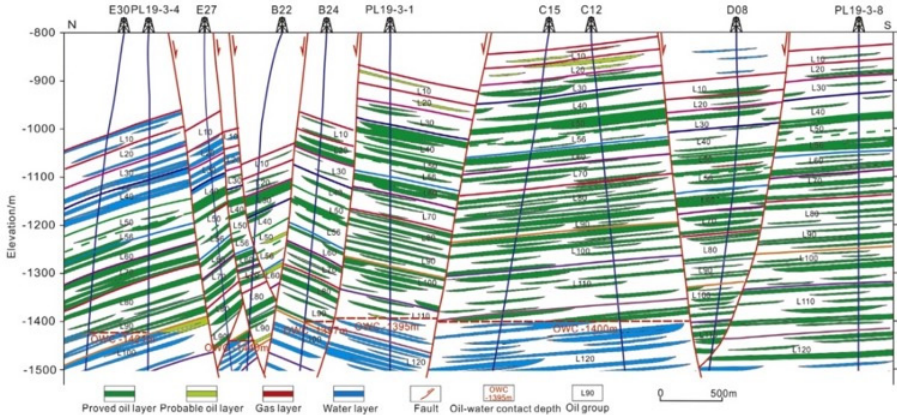
Figure 2. The PL Oilfield reservoir profile [29] . The oil and gas is locally controlled by sandstone pinchout, which is a typical lithologic − structural reservoir.